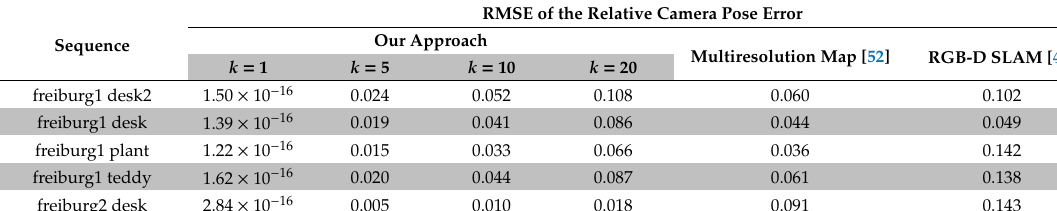
Table 2. Camera pose error for datasets with ground-truth from [44] in terms of RMSE of the relative error. The value of k is the number of training RGB images in a viewpoint class in our approach, and the stride to select the key-frames from the training datasets in other approaches.